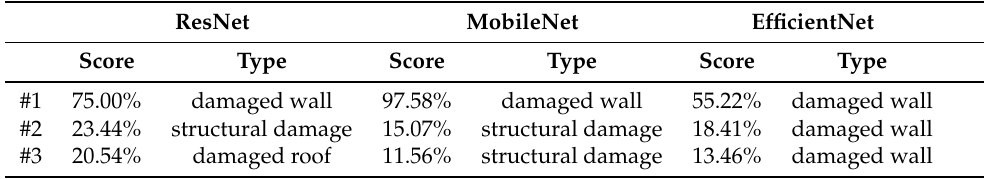
Table 5. Summary of confidence scores and associated object categories for the top three predictions made on the image of a damaged wall for each of the three